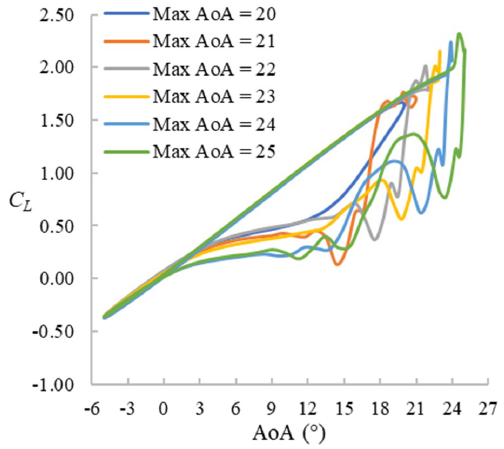
Figure 6. C L hysteresis loops for f = 0.1 cases.